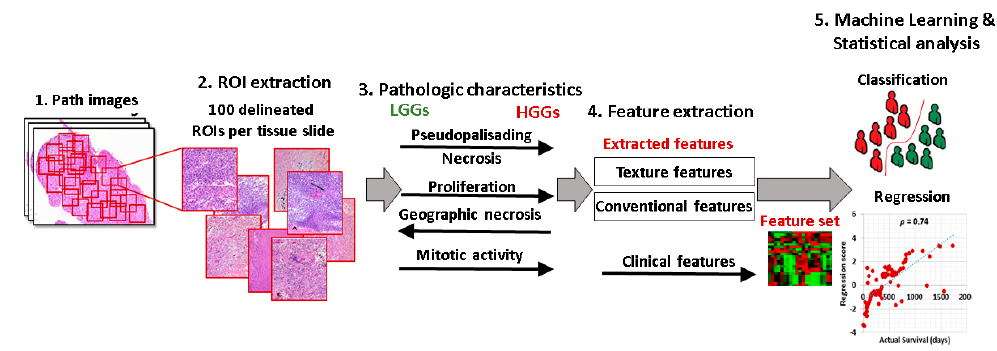
Figure 6. Schematic of the proposed method .